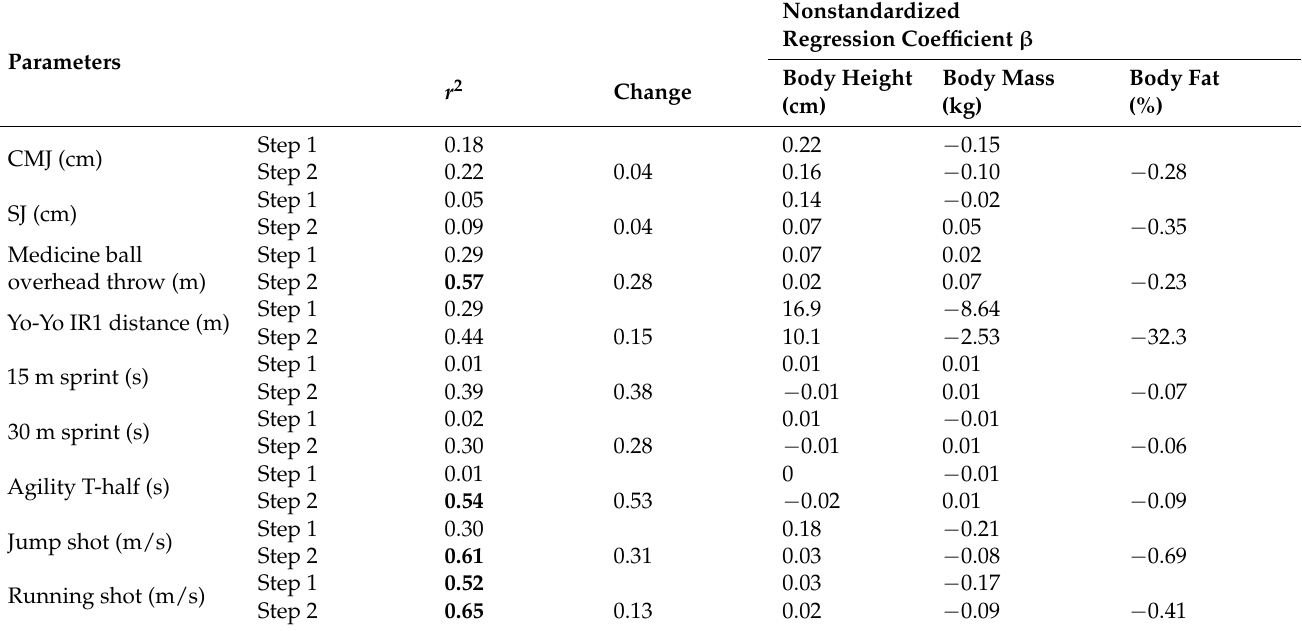
Figure 2. Relationship between body fat and aerobic capacity depending on the group. Please note that one dot can represent several subjects.